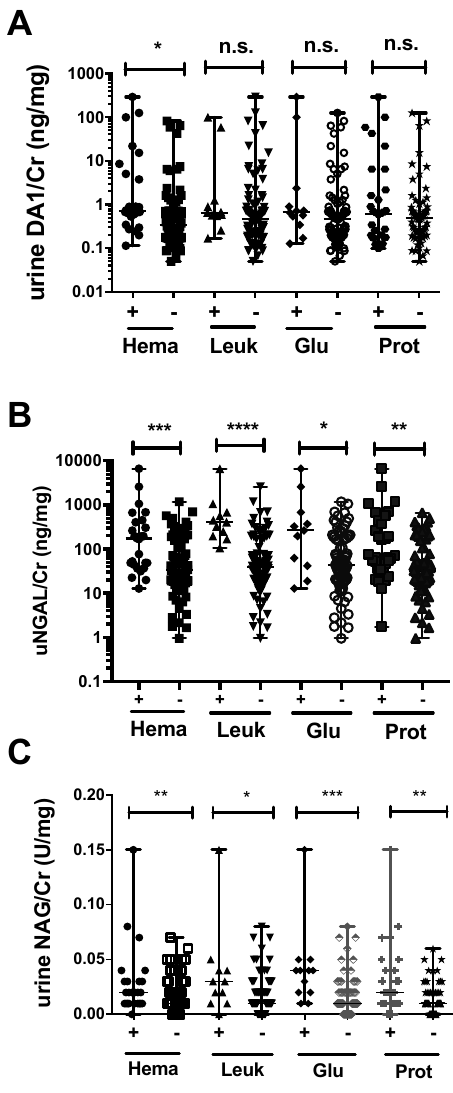
Figure 4. Urinary levels of DA1 ( A ); NGAL ( B ); and NAG ( C ) in hematuria (Hema)-, leukocyte (Leuk)-, glucose (Glu)-, and proteinuria (Prot)-positive or -negative groups among leptospirosis patients. * p < 0.05, ** p < 0.01, *** p < 0.001, **** p < 0.0001, n.s. not significant.